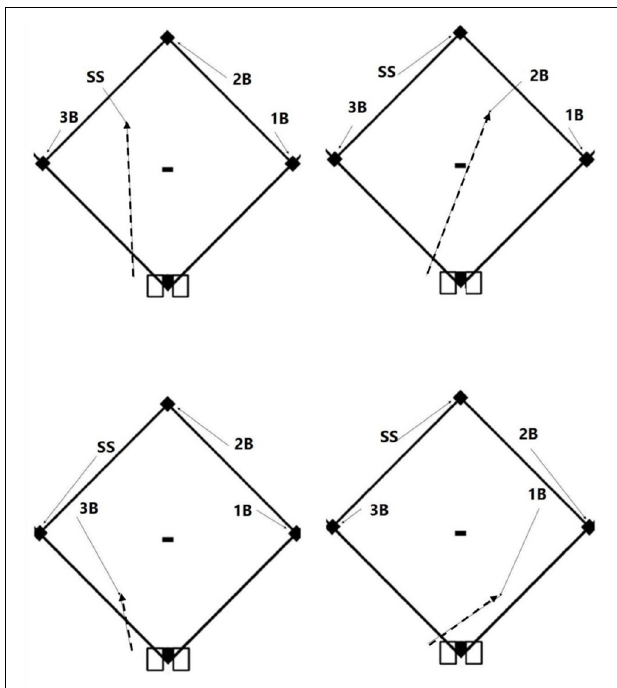
FIGURE 1 | Illustration of coordination in a baseball infield. Depending on the trajectory of the batted ball (dashed lines), each player must decide whether to attempt to move to intercept the ball (i.e., “field it”) or to move so that they can receive a ball thrown to one of the bases (black diamonds). Each of the four panels illustrates how players are typically taught to move (dotted lines) depending on which player fields the ball. 1B = first baseman, 2B = second baseman, SS = shortstop, 3B = third